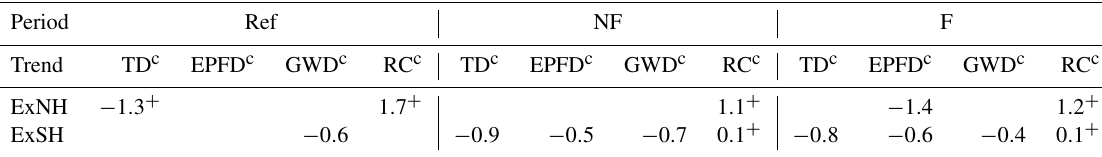
Table 1. Upward-shift-corrected trend values ( c ) of total drag (TD, EPFD + GWD) and its components EPFD and GWD multiplied by (cid:104) F period. Presented are trend values significant at least at the 90% confidence level or at least at the 75% confidence level (denoted by superscript + ); otherwise, the cell is left